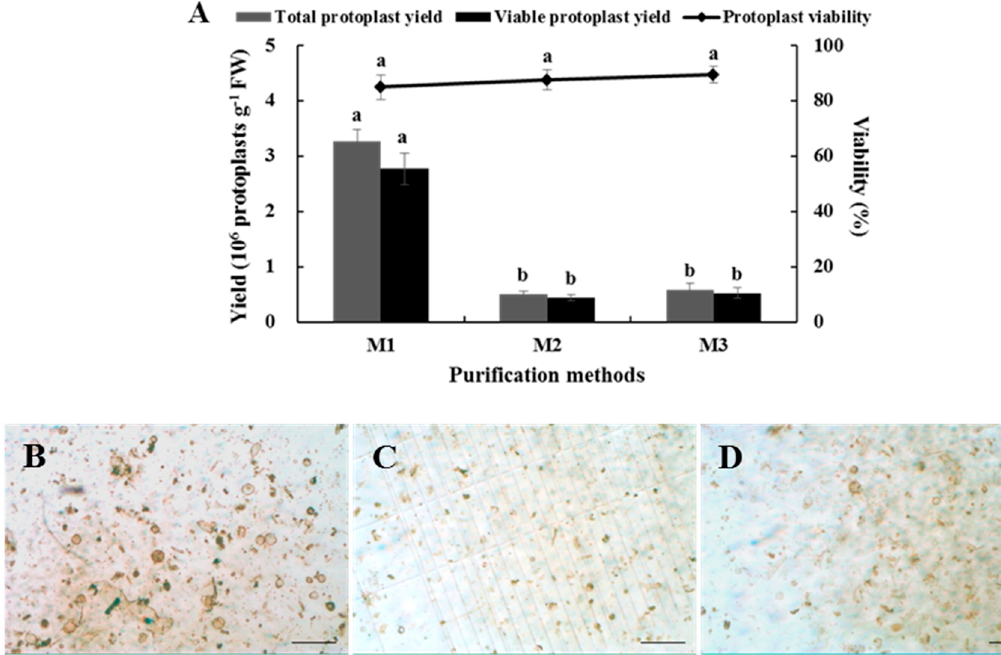
Figure 5. Effects of purification method on yield, viability, and purity of Chinese kale hypocotyl protoplasts. ( A ) Resulting yield and viability. M1: before purification; M2: floating method; M3: precipitation method. Light microscopy images ( B ) Before purification; ( C ) After purification by floating method; ( D ) After purification by precipitation method. Scale bars in (B–D) = 200 μ m.